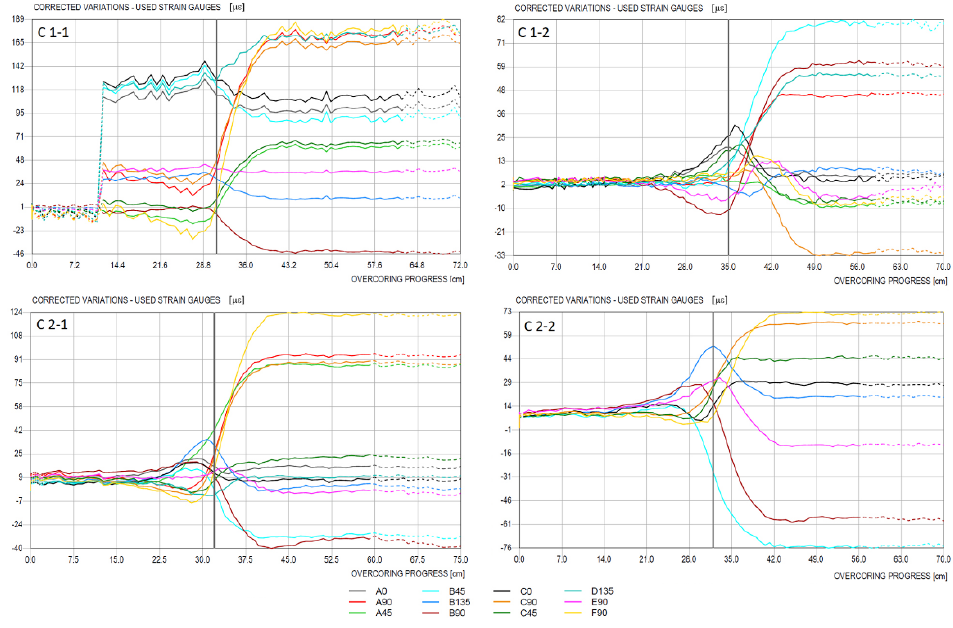
Figure 12. Graphs of the CSIRO HI cells correlating the deformations ( µε ) registered by the 12 oriented strain gauges versus the borehole depth (cm).